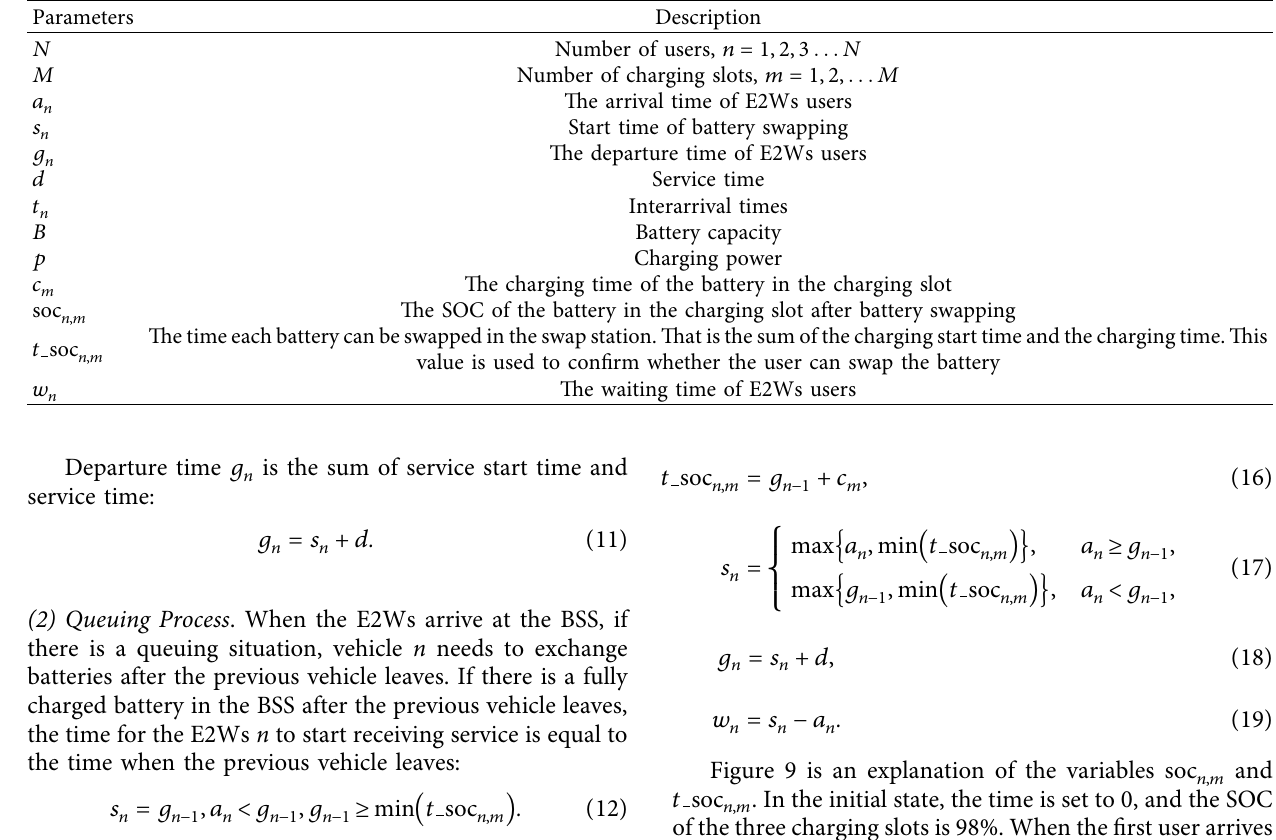
Table 4: Te parameters in the queuing model.